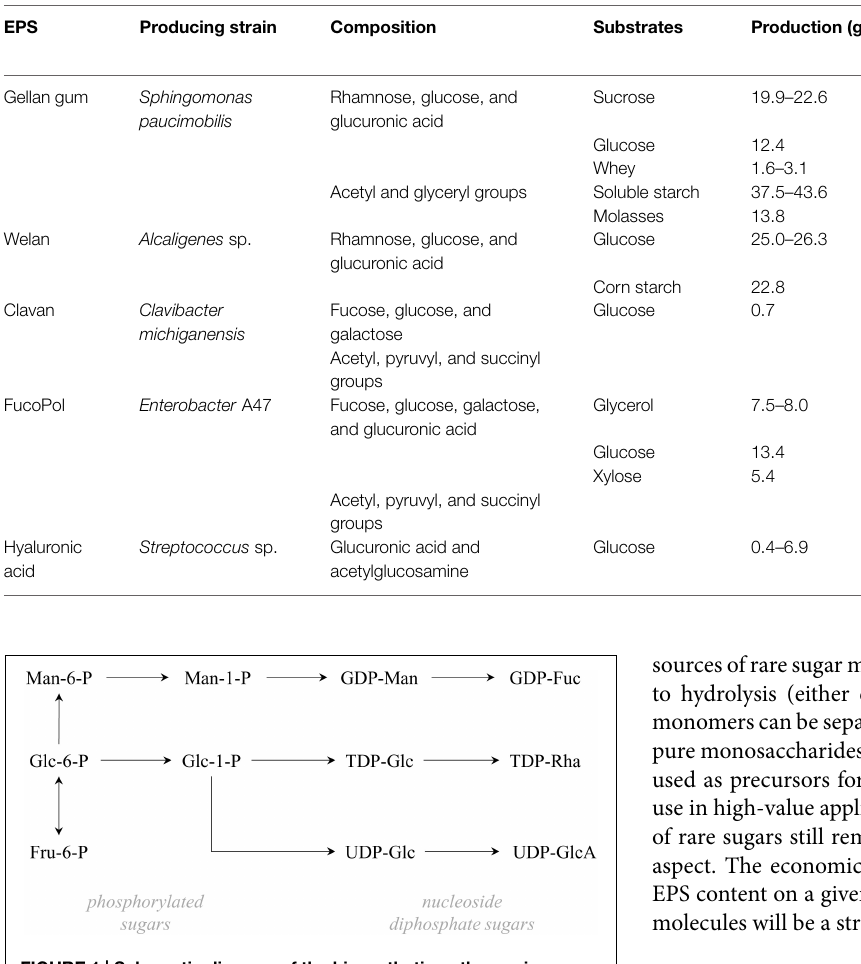
FIGURE 1 | Schematic diagram of the biosynthetic pathways in Gram-negative bacteria involved in the intracellular synthesis of nucleoside diphosphate sugars that are precursors of some rare sugar monomers (Fuc, fucose; Glc, glucose; GlcA, glucuronic acid; Man, mannose; Rha, rhamnose; Fru, fructose; GDP, guanosine diphosphate; TDP, tyrosine diphosphate; UDP, uridine